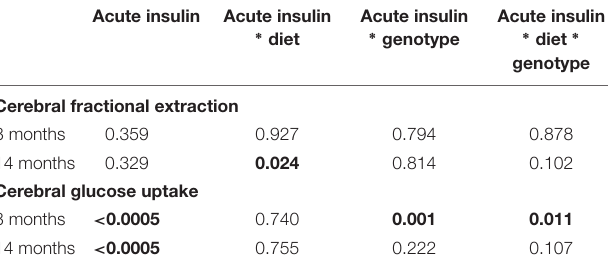
TABLE 3 | Mixed design ANOVA for the effects of acute intranasal insulin